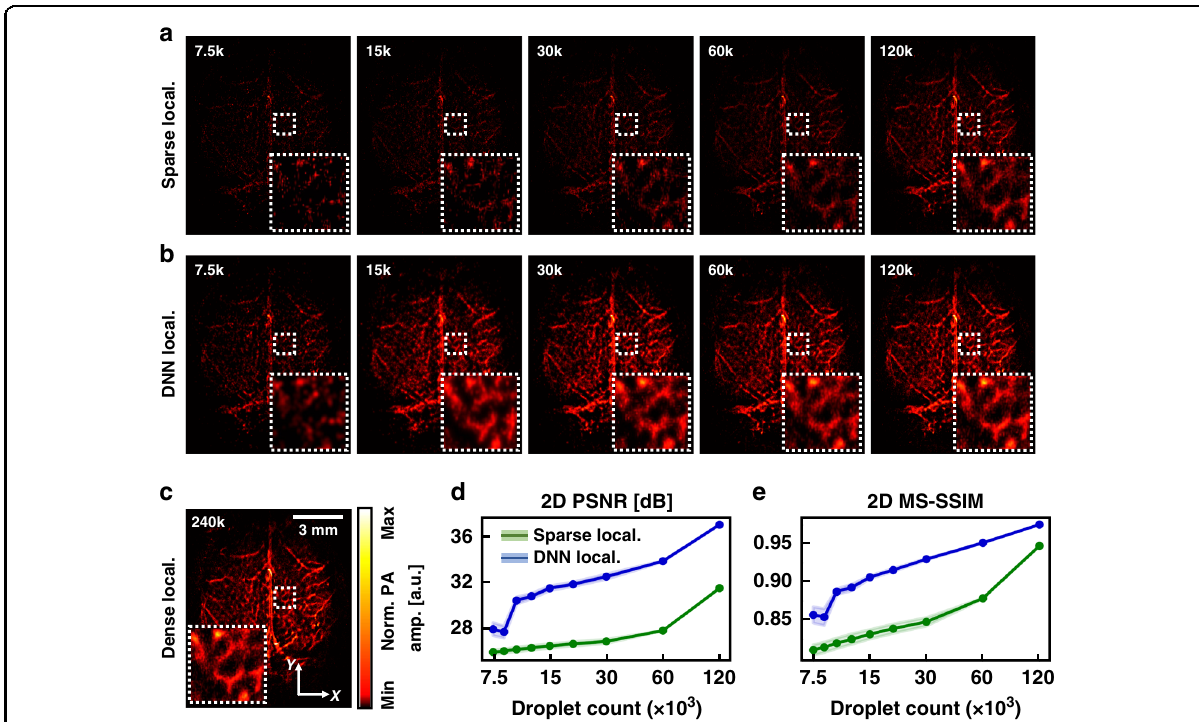
Fig. 5 Performance of 2D deep-learning localization PACT as a function of droplet counts. a Sparse localization PACT images reconstructed with droplet counts of 7.5k, 15k, 30k, 60k, and 120k. b DNN localization PACT images generated from parse images. c A dense localization PACT image reconstructed with 240k droplets. All images correspond to images in Fig. 4. Graphs for d 2D PSNR and e 2D MS-SSIM evaluation metrics for droplet counts of 7.5k, 8.6k, 10k, 12k, 15k, 20k, 30k, 60k, and 120k. PACT photoacoustic computed tomography, PA photoacoustic, Sparse local. sparse localization-based PA image, DNN local. deep neural network localization-based PA image, Dense local. , dense localization-based PA image, Norm. PA amp. normalized PA amplitude, PSNR peak signal-to-noise ratio, MS-SSIM multiscale structural